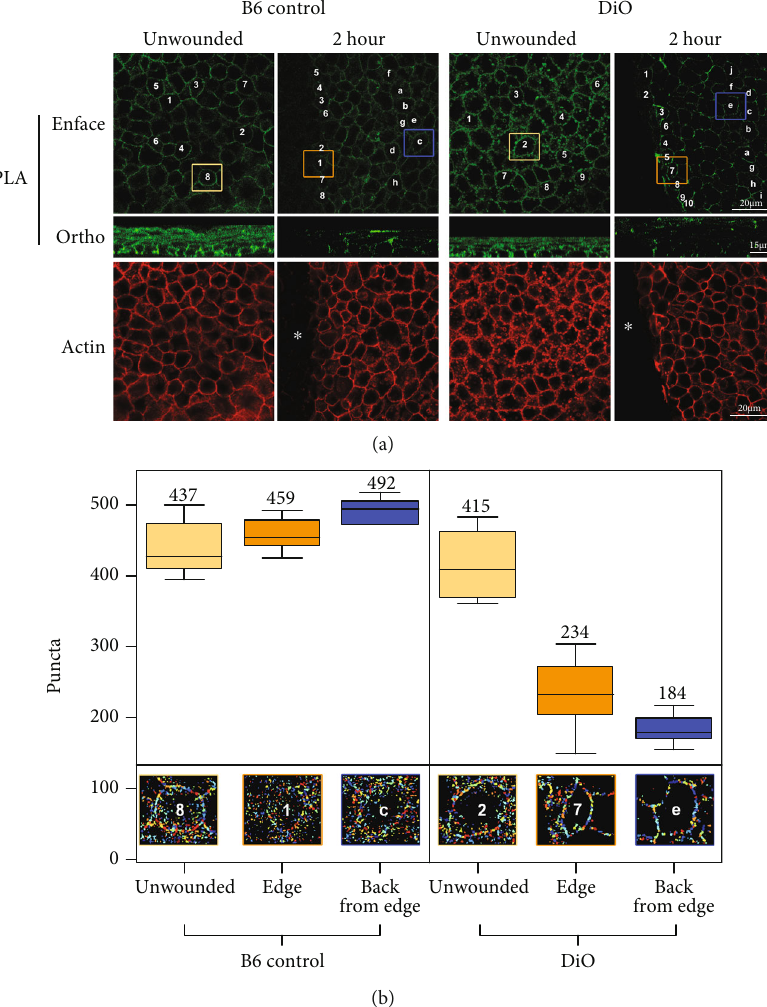
Figure 4: Association of pannexin1 and P2X7 in unwounded corneas and 2hrs after injury in DiO and B6 control corneal epithelium. Proximity ligation assays were performed using antibodies to P2X7 and pannexin1. (a) Representative enface and orthogonal (ortho) images of B6 control and DiO corneas are shown. The green color displays puncta of association. Corneal epithelium was counter stained with rhodamine phalloidin (asterisk marks wound area). The numbers and letters mark the individual cells that were analyzed using CellPro fi ler near the wound and back from the wound. The boxes indicate the representative individual cells that are shown in (b) after PLA analysis with CellPro fi ler. Bar equals 20 microns (PLA enface and actin) or 15 microns (PLA ortho). (b) Analysis of overlapping puncta for each condition (unwounded, leading edge, back from leading edge) was performed and a box plot drawn using R. The mean puncta for each region are placed above the box. Mean ± SEM are plotted, and two-way ANOVA with Tukey ’ s multiple comparison of means was performed. p < 0 : 05 . N is a minimum of 3 independent